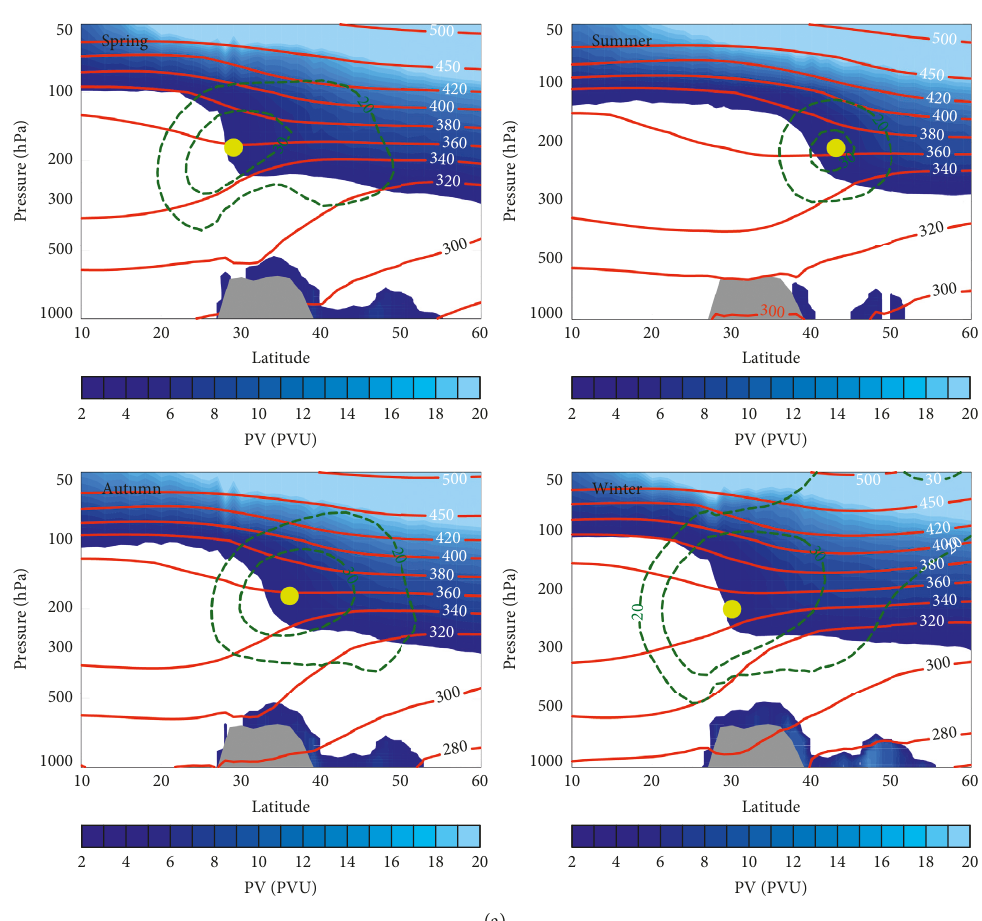
Figure 6: Pressure-latitude cross sections of seasonal average PV (color shadings; pvu), potential temperature (red lines; K), and zonal winds (green dashed lines; m/s) along 90 ° E during 1979–2018. The yellow dots represent the jet core. The area shaded in gray denotes the TP